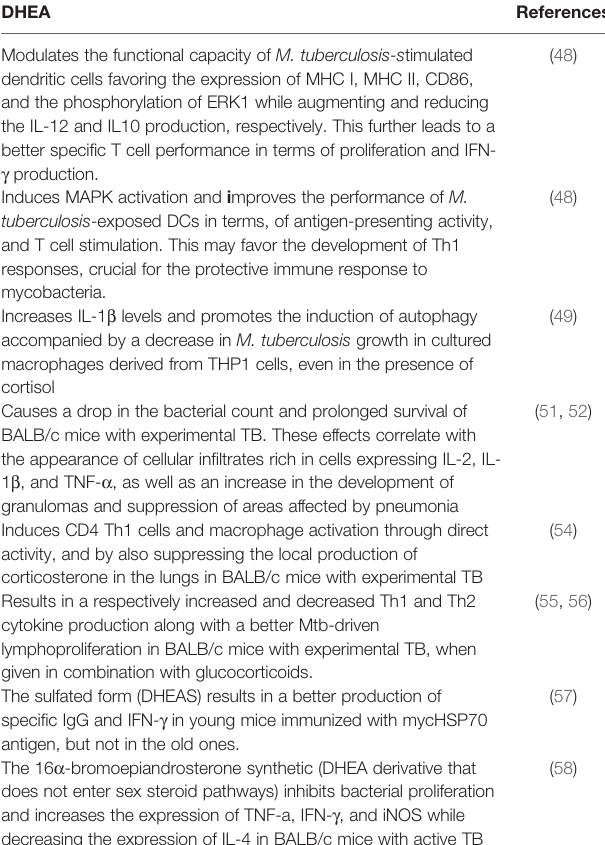
TABLE 1 | Bene fi cial Effects of DHEA in